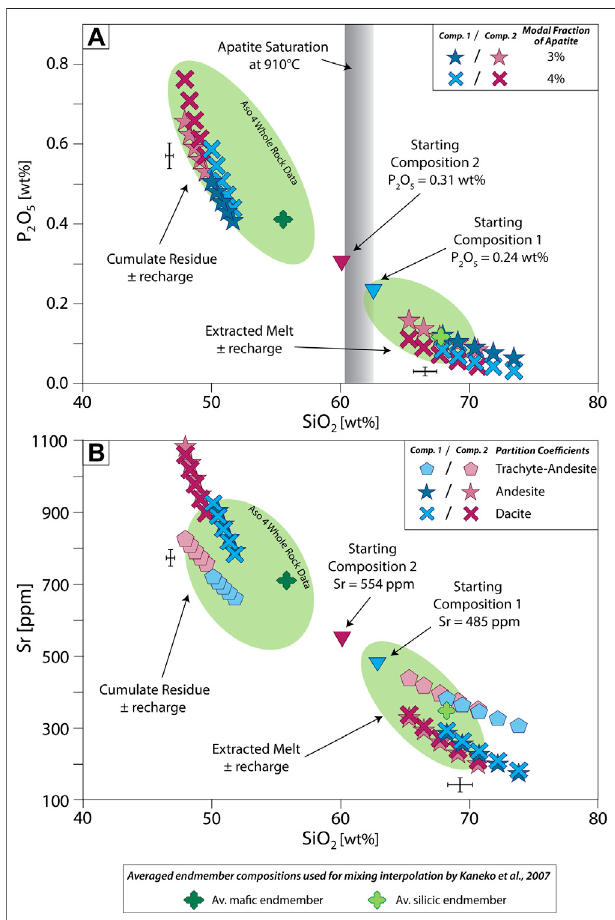
FIGURE9| Majorandtraceelementmodelingusing (A) P 2 O 5 and (B) Sr vs. SiO 2 based on Rayleigh fractionation. Starting compositionsof twonatural samples of intermediate composition (1 (cid:2) blue, 2 (cid:2) purple) are marked as triangles. Modal proportions used to calculate bulk partition coef fi cients appliedinthemodelcalculationsweregiveninKanekoetal.,(2007).However, in P 2 O 5 models (A) modal fractions for apatite were varied between 3% and 4%. In Sr models (B) partition coef fi cients for Sr in plagioclase were varied for different melt compositions. Green fi elds illustrate Aso-4 whole rock data, green symbols represent the endmembers used for mixing modulations in Kaneko et al., (2007). Error bars indicate the 2 σ error of the respective modeled element concentrations.